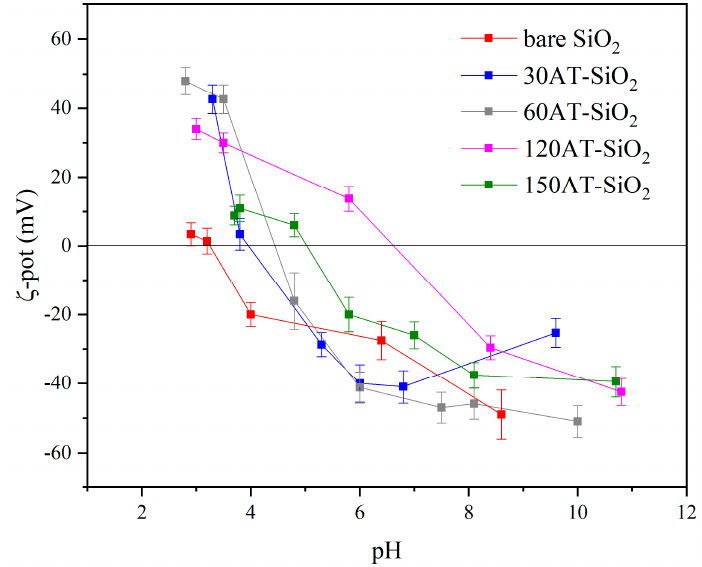
Figure 8. ζ -potential curve of all synthesized samples in deionized water at room temperature.